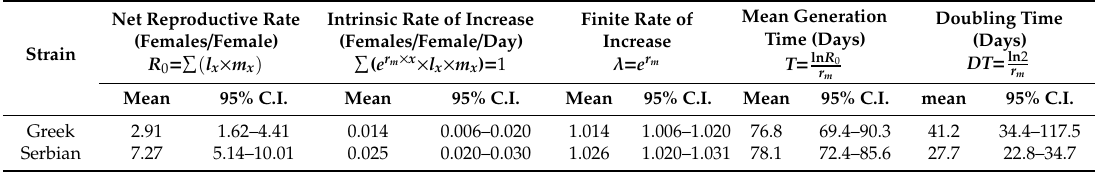
Table 3. Demographic parameters of two strains of Tribolium confusum (mean, 95% C.I.) fed on cracked